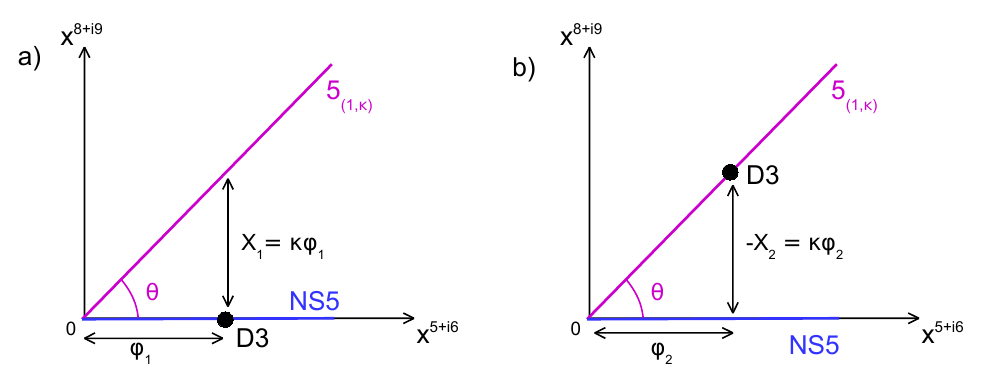
Figure 15 . Brane setups with the reconnected D3 segment displaced (a) along x 5+ i 6 (cid:17) x 5 + ix 6 for the branch I, ( b ) along x 5 (cid:0) 8 + ix 6 (cid:0) 9 for the branch II. Here tan (cid:18) =